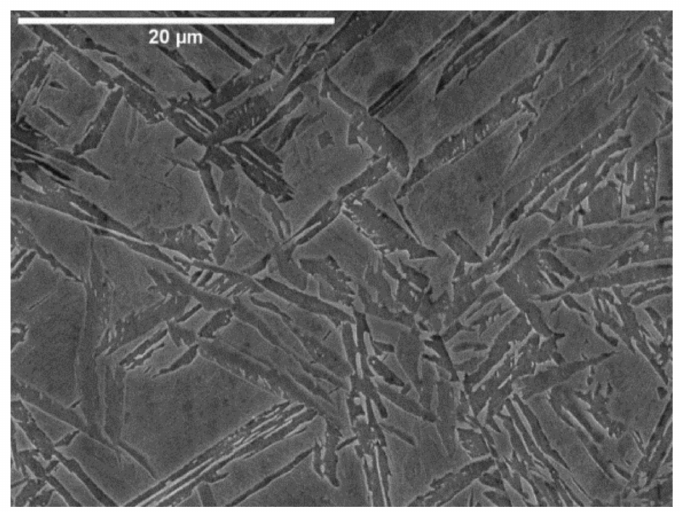
Figure 4. Micrograph of the sample held at 450 ◦ C for 20 s.